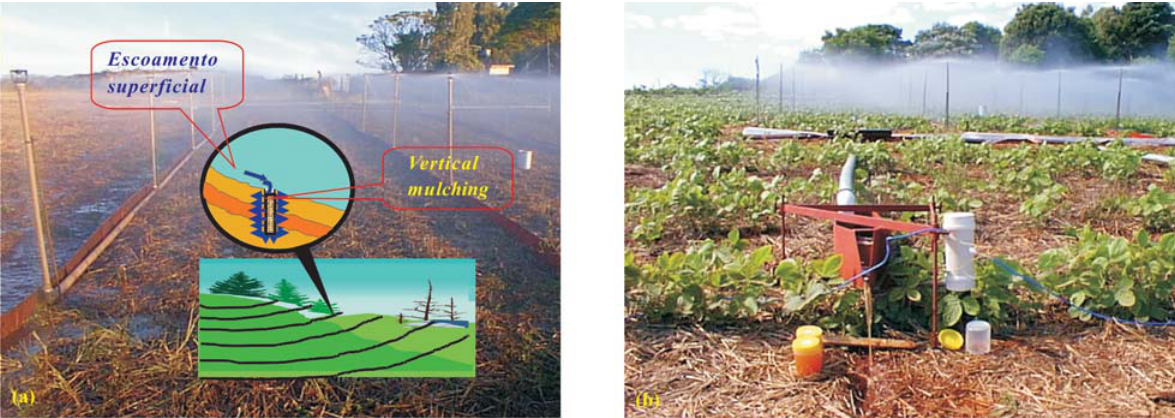
Figura 2. Simulação de chuva em um dos blocos e (a) detalhe da localização do vertical mulching em uma lavoura; (b) vista da parcela com a simulação de chuva e determinação do escoamento superficial por meio da